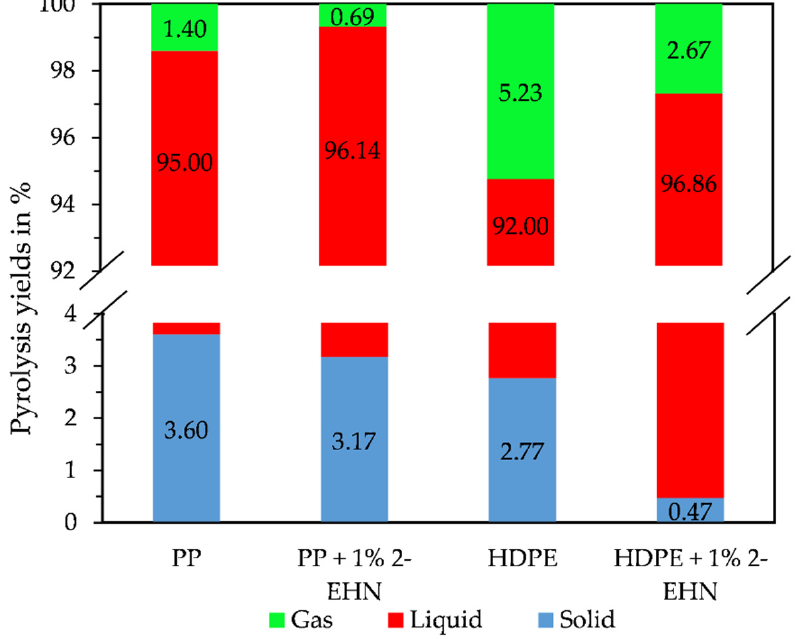
Figure 3. Yield of solid (blue), liquid (red) and gas (green) during pyrolysis of PP, PP + 1% 2 ‐ EHN, HDPE, HDPE + 1% 2 ‐ EHN.